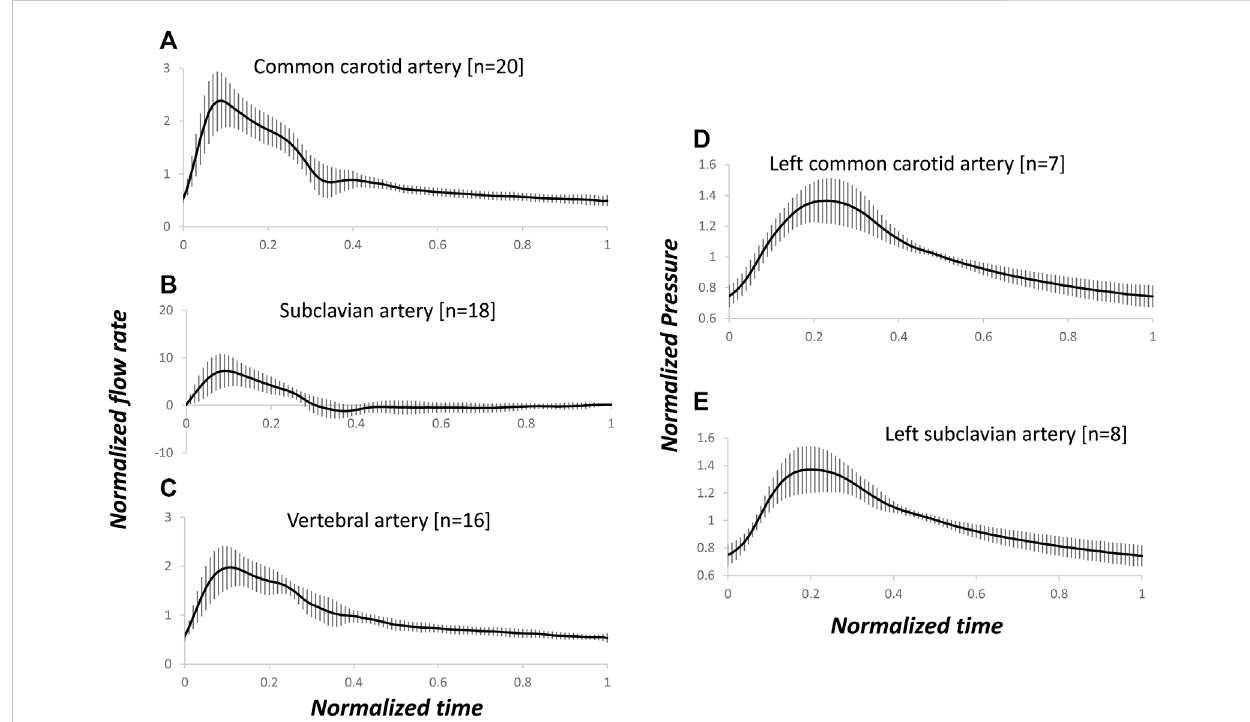
FIGURE 2 Arterial-speci fi c, pre-operative, normalized fl ow rate and pre-deployment, normalized pressure waveforms. The fl ow rate and pressure were normalized by the corresponding mean of each waveform. Average and standard deviation of fl ow rates in common carotid (A) , subclavian (B) and vertebral (C) arteries, and pressure in left common carotid (D) and subclavian (E) arteries. The number of measured blood vessels, n, is also